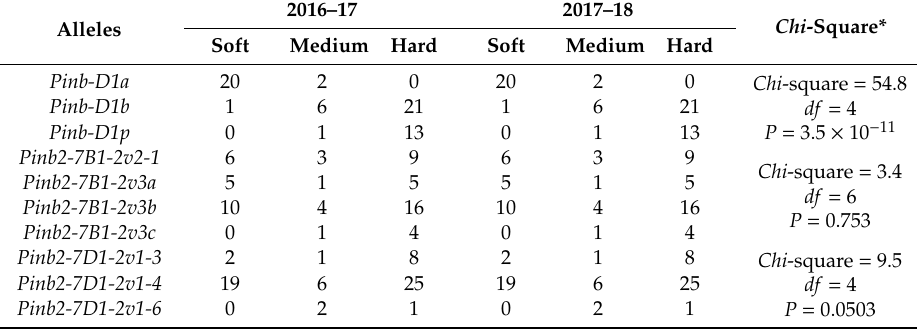
Table 2. Chi -square analysis of the association between Pinb , Pinb2-7B1 or Pinb2-7D1 loci with kernel hardness.